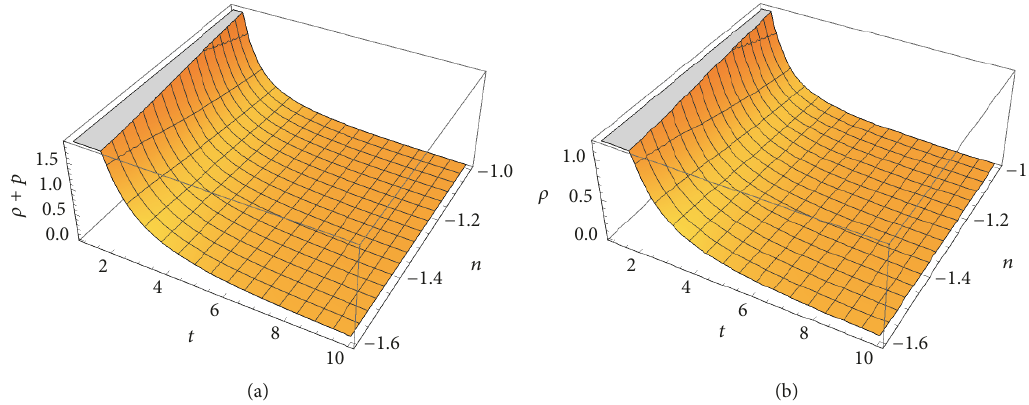
Figure 1: (a) Behavior of 𝜌 + 𝑝 for 𝑚 = −1/2 with 𝜅 = 1 . (b) Behavior of 𝜌 for radiation universe.